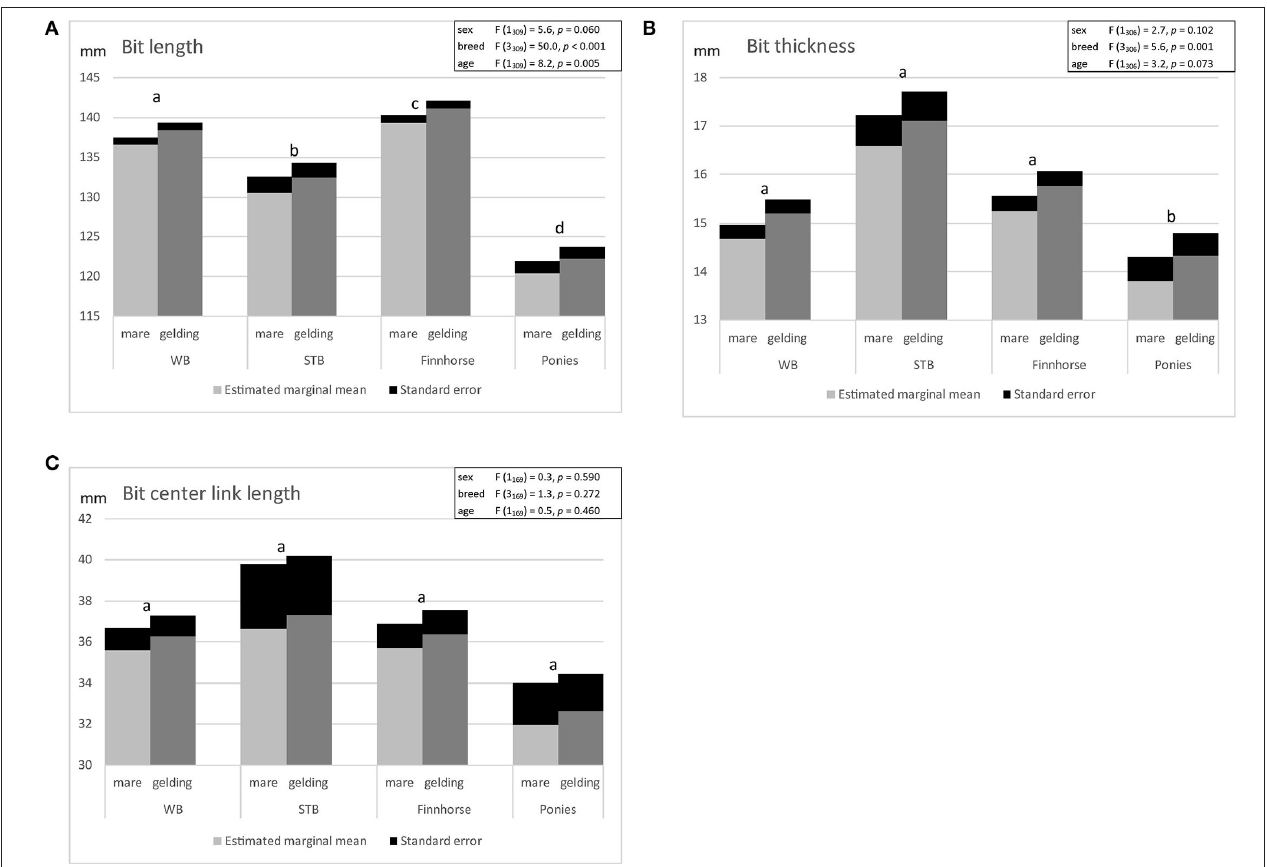
FIGURE 4 | Estimated marginal means of linear regression model of bit mouthpiece size in mares and geldings of different breeds [Warmblood (WB), Standardbred (STB), Finnhorses, ponies] of adult horses and ponies ≥ 5 years: (A) bit length, (B) bit thickness, (C) bit center link length (significant differences between breeds marked by differing letters).